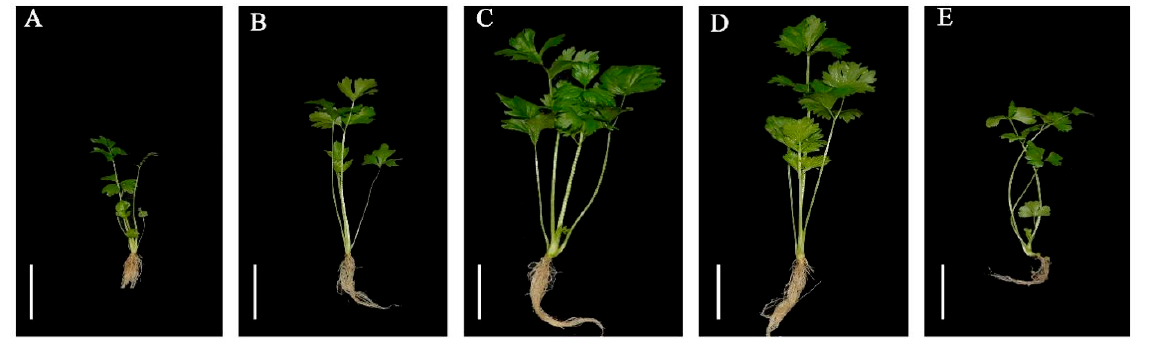
Figure 1. Effects of 24-EBL treatments on celery growth, with celery at 50 DAG. ( A ) Control; ( B ) 8.32 × 10 − 7 mol/L 24-EBL treatment; ( C ) 1.24 × 10 − 6 mol/L 24-EBL treatment; ( D ) 1.66 × 10 − 6 mol/L 24-EBL treatment; ( E ) 2.08 × 10 − 6 mol/L 24-EBL treatment. Scale bars = 5 cm.